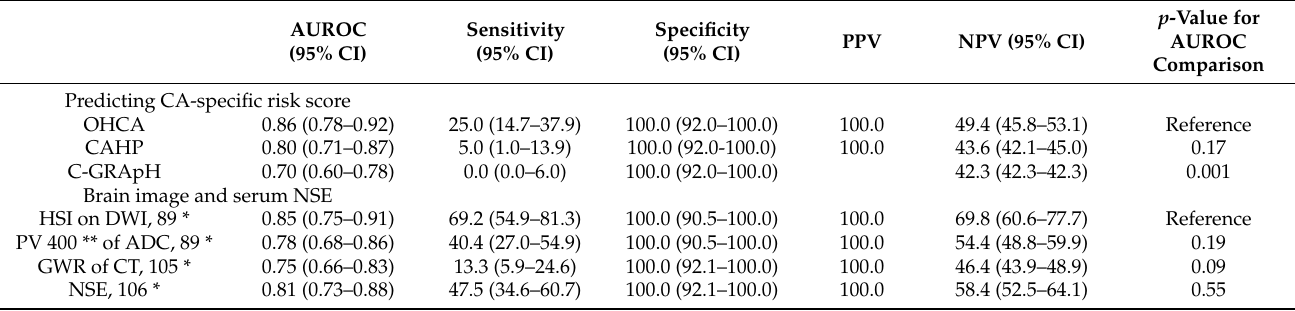
Table 2. A comparison of AUROC values for prediction scores, brain image, and serum NSE to predict poor neurological outcome at 3 months after ROSC.